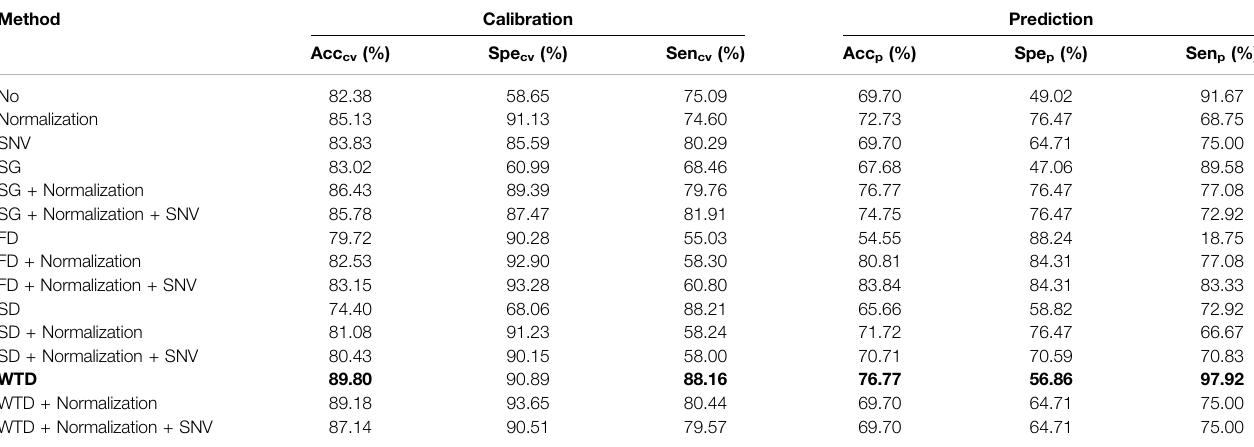
TABLE4| ModelperformancesofthePLS-DAmodelusingRamanspectraldatawithdifferentpreprocessingmethods.(ThebestprocessingmethodforthePLS-DAmodel are presented in bold). Method